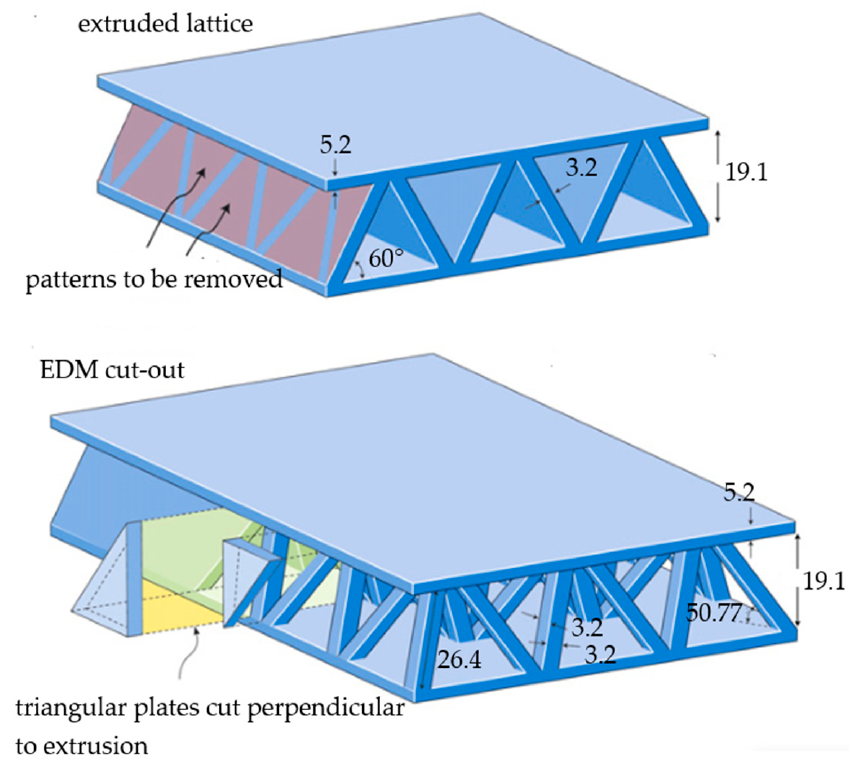
Figure 11. Extrusion and electro-discharge machining method [122].